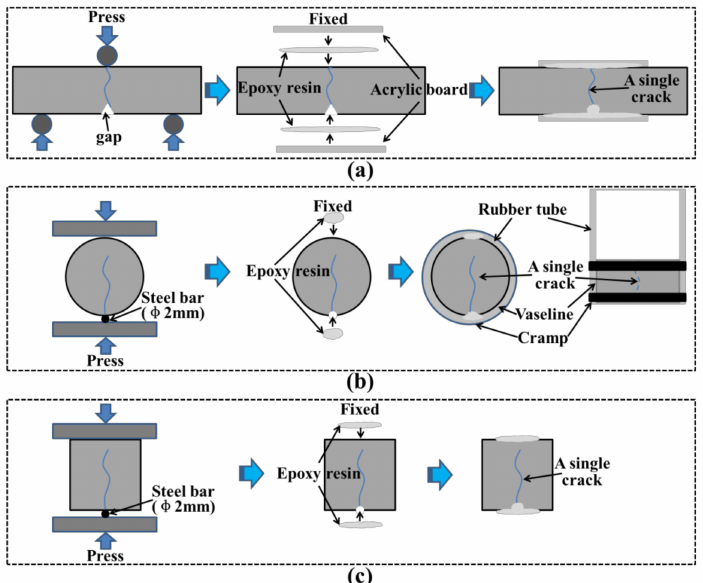
Figure 1. Schematic diagram of a single crack preparation: ( a ) a single crack prepared in prisms by three-point bending procedure, ( b ) a single crack prepared in cylinders by split test procedure, ( c ) a single crack prepared in cubes by split test procedure.